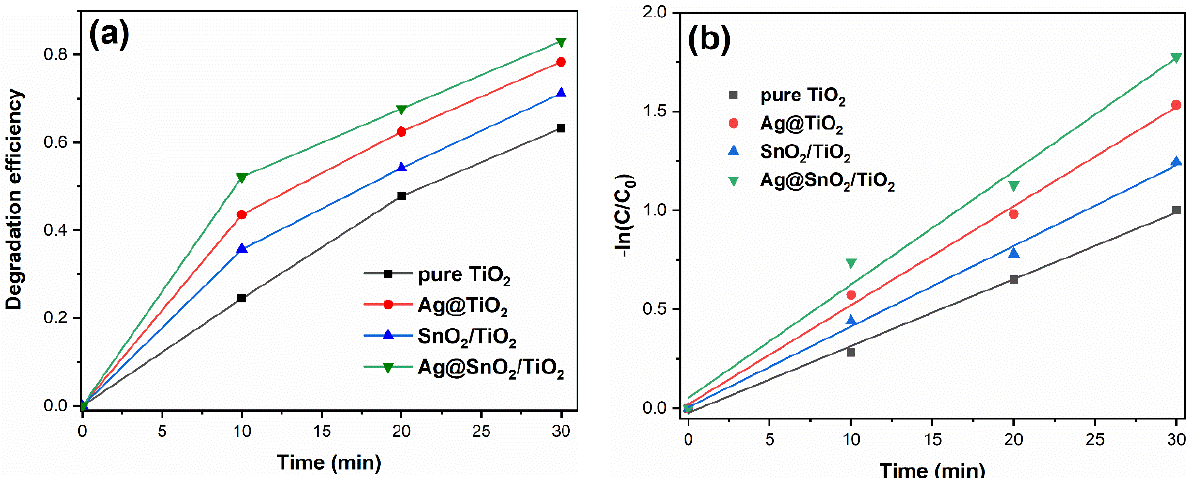
Figure 8. Degradation curves ( a ) and the kinetic curves of samples ( b ). Ag decoration and SnO 2 coupling are beneficial to the separation of photogenerated charges and quantum efficiency, which has been proven by PL spectra. When Ag decoration and SnO 2 coupling are implemented simultaneously, a synergistic effect on suppressing the recombination of photogenerated electrons and holes is yielded. Therefore, Ag@SnO 2 /TiO 2 shows the lowest PL peak intensity, exhibiting the highest photocatalytic activity. To determine the active species in photocatalytic reaction process, benzoquinone (BQ), ammonium oxalate (AO) and isopropanol (IPA) were added to capture the ac- tive groups, such as · O 2 − , h + and · OH, during the TC photodegradation process by Ag@SnO 2 /TiO 2 [51,52]. The results are shown in Figure 9. The degradation degree de- clines from 82.3 to 10.5% after adding BQ. The clearly decreased degradation degree indicates that · O 2 − radicals are the main active groups. The degradation degrees are 40.9 and 67.9% after adding AO and IPA, separately, implying that the holes and · OH radicals play secondary roles in the degradation